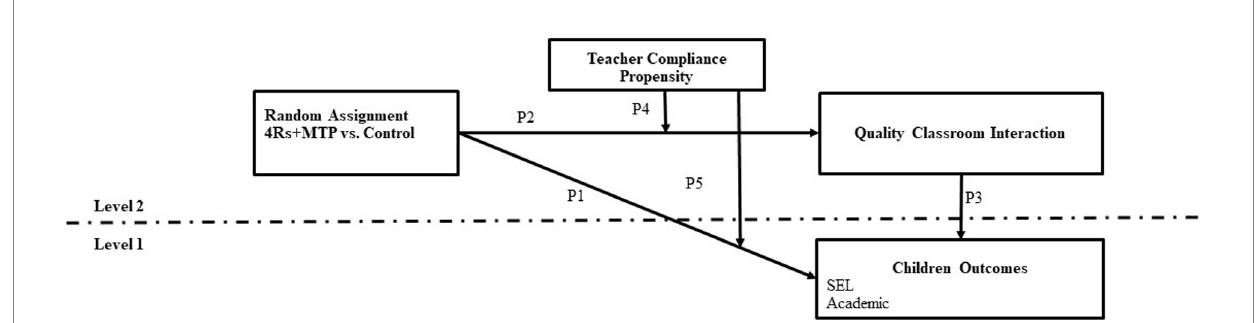
FIGURE 2 Multilevel moderated mediation model. Level 1 refers to variables at the child level, and level 2 refers to variables at the teacher and classroom level. P1–P5 refer to paths representing the relationships between